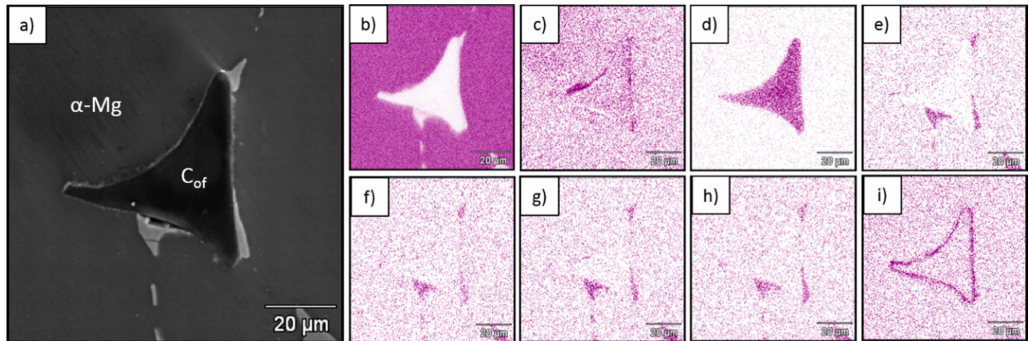
Figure 4. SEM micrograph of C of 100ppi–RZ5 composite ( a ) and EDS mapping of ( b ) Mg, ( c ) O, ( d ) C, ( e ) Zn, ( f ) La, ( g ) Ce, ( h ) Nd and ( i ) Zr.